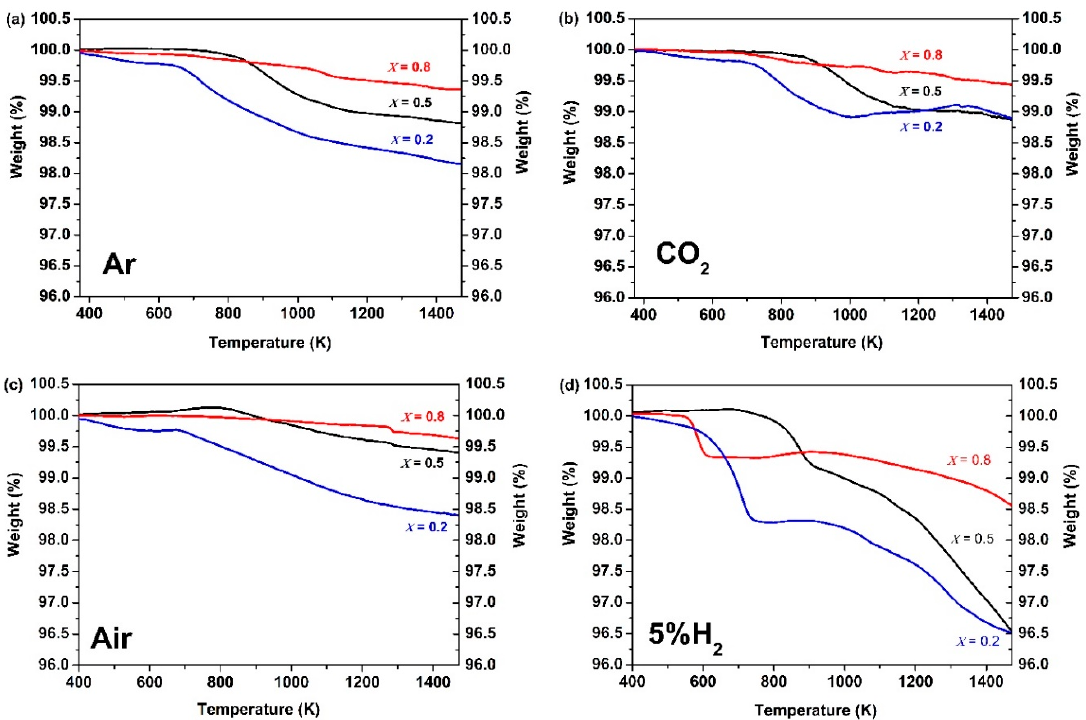
Figure 3. Thermogravimetric (TG) curves of Ce 0.9 Pr 0.1 O 2 − δ –Nd x Sr 1– x Fe 0.9 Cu 0.1 O 3 − δ ( x = 0.2, 0.5, 0.8) dual-phase membranes under flowing ( a ) Ar, ( b ) CO 2 , ( c ) air and ( d ) 5 vol% H 2 -95 vol% Ar atmospheres (heating rate: 10 K min − 1 ).